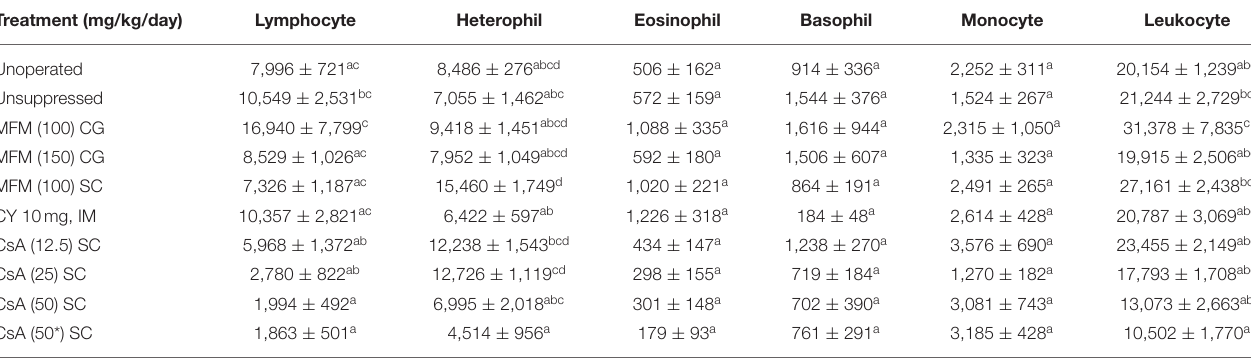
TABLE 5 | Concentration of circulating leukocytes and their subsets, from Study